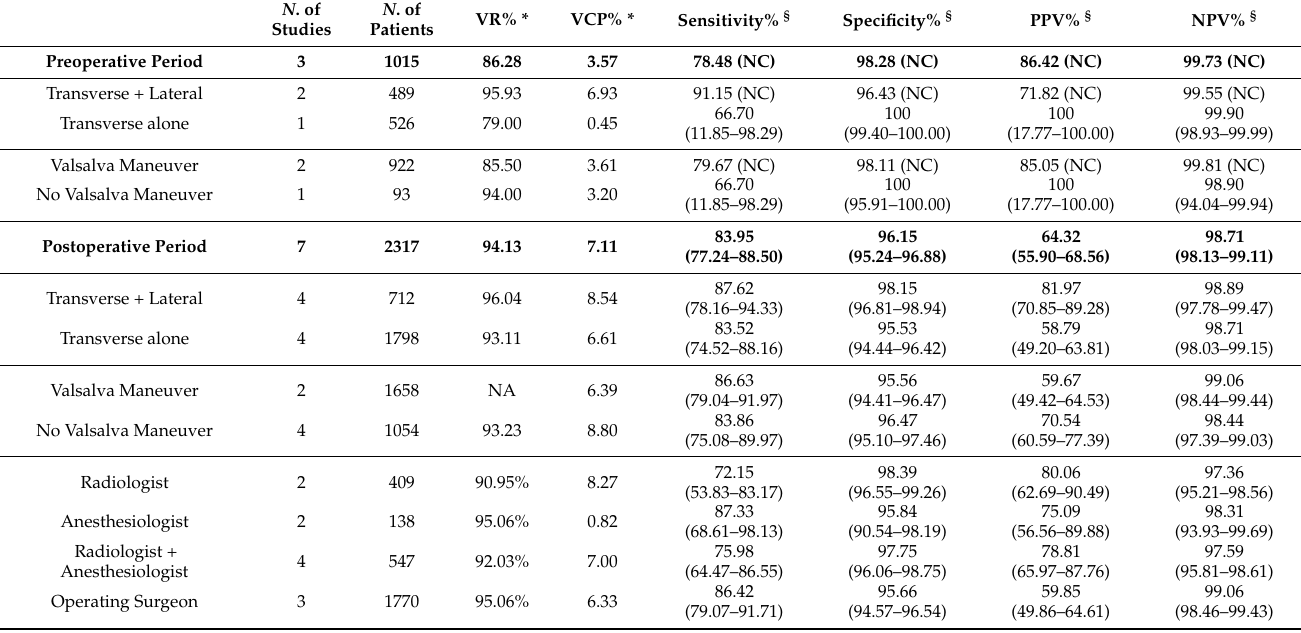
Table 2. Weighted arithmetic means of diagnostic accuracy of TLUSG in the preoperative and postoperative period. N . of